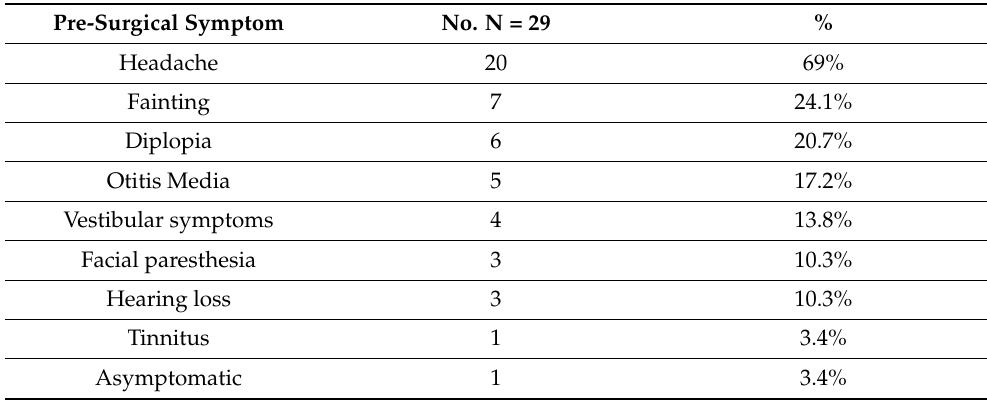
Table 1. Pre-surgical symptoms of patients affected with cholesterol granuloma of the apex petrous. In some patients, more than one symptom was